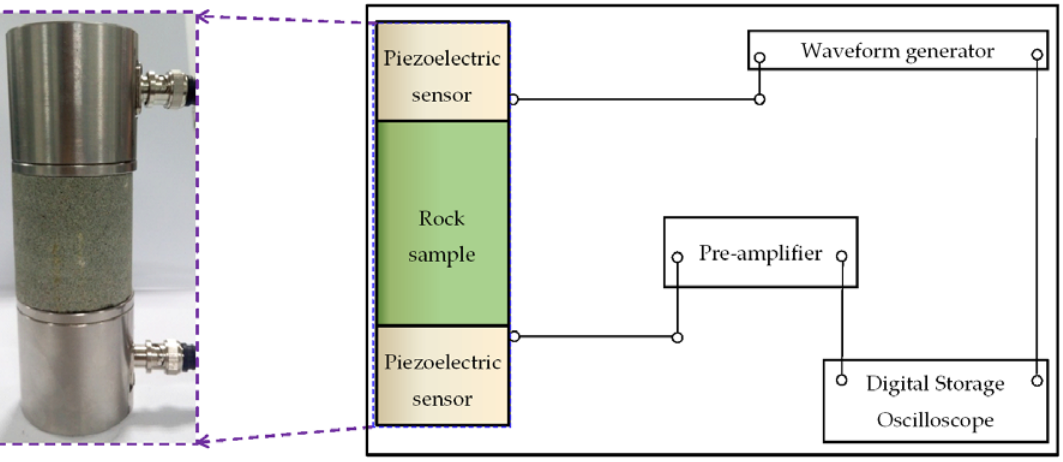
Figure 3. Ultrasonic measuring instrument setup.